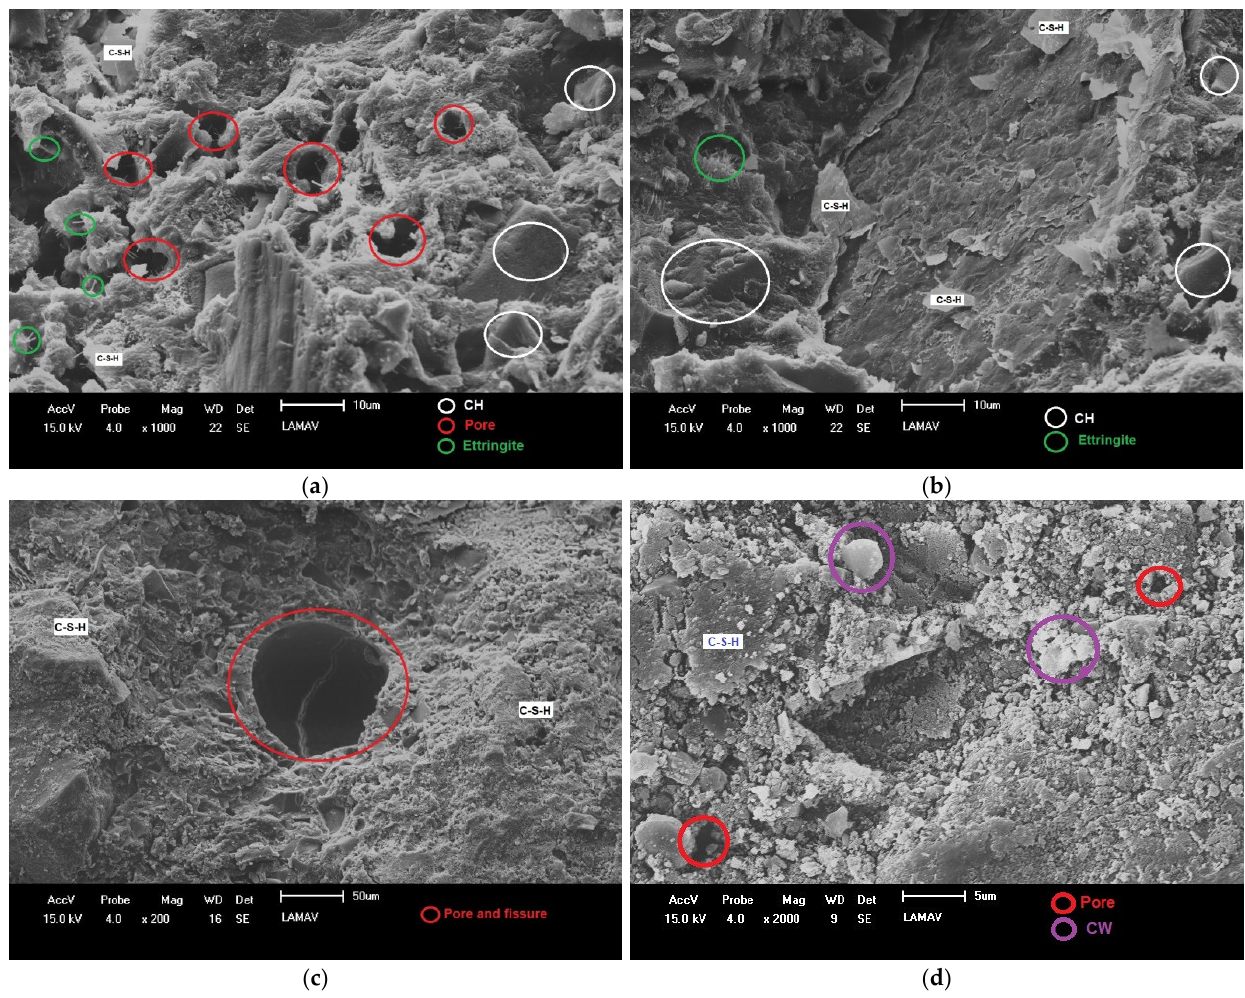
Figure 8. SEM of the studied concretes: ( a ) and ( b ) C0%; ( c ) and ( d ) C20%.